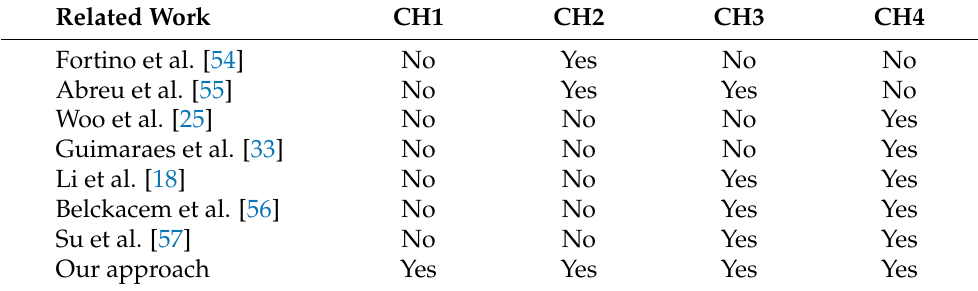
Table 1. Challenge addressed by the related